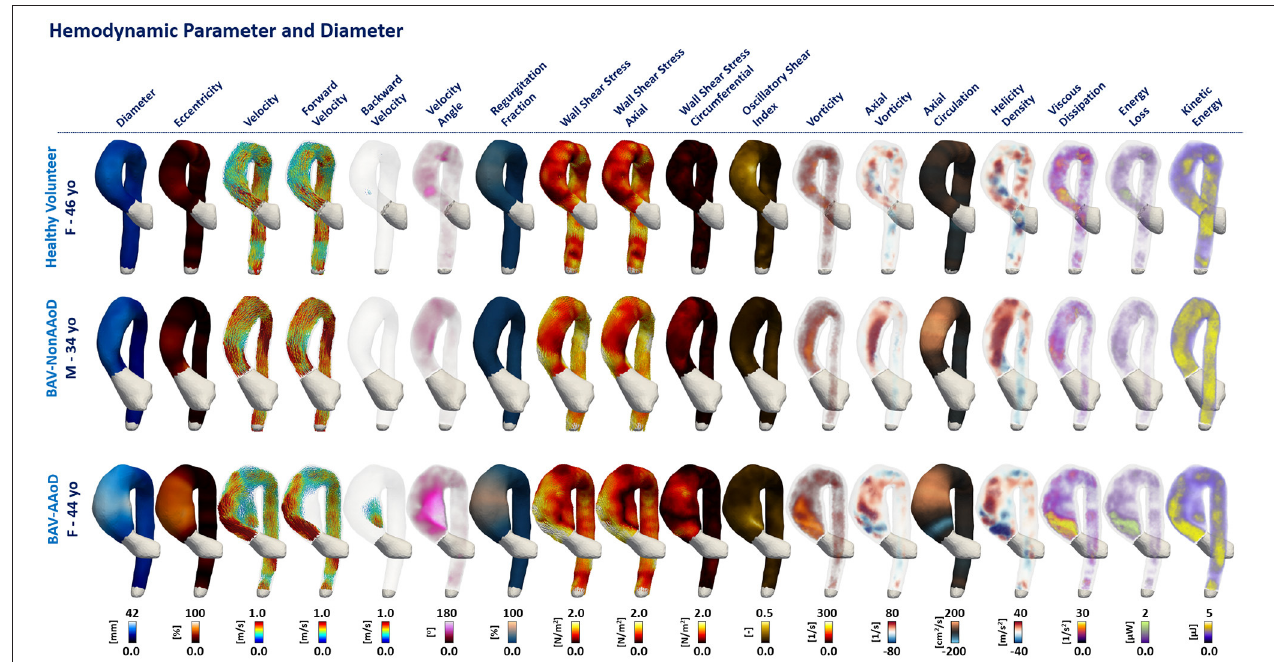
FIGURE 2 | Three-dimensional maps of a representative HV and patients with BAV. Columns represent each analyzed parameter ( Figure 1C ). First row shows a HV, second row a non-dilated BAV (BAV-Non-AAoD) patient, and third row a patient with BAV with ascending aorta dilation